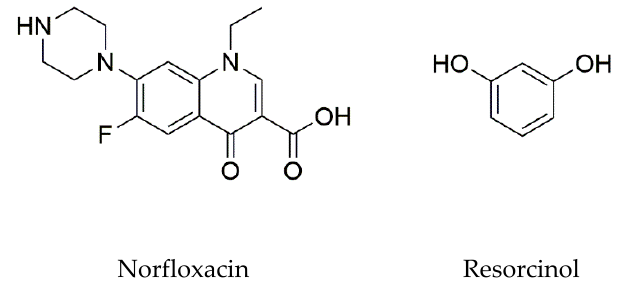
Figure 1. Molecular structures of Norfloxacin and resorcinol .